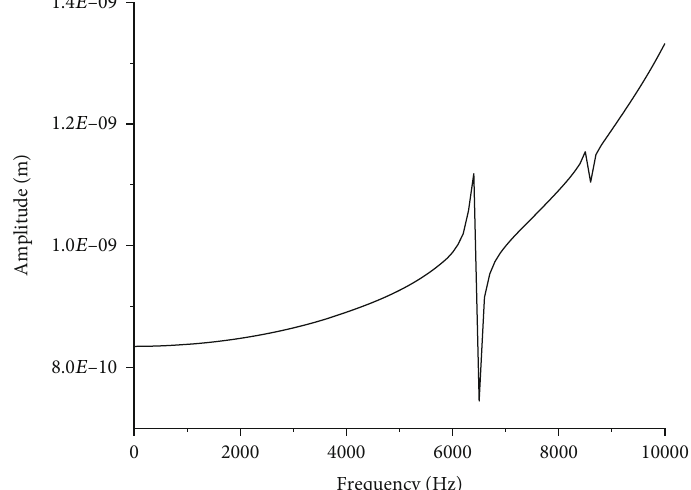
Figure 7: Sensor resonance frequency response.